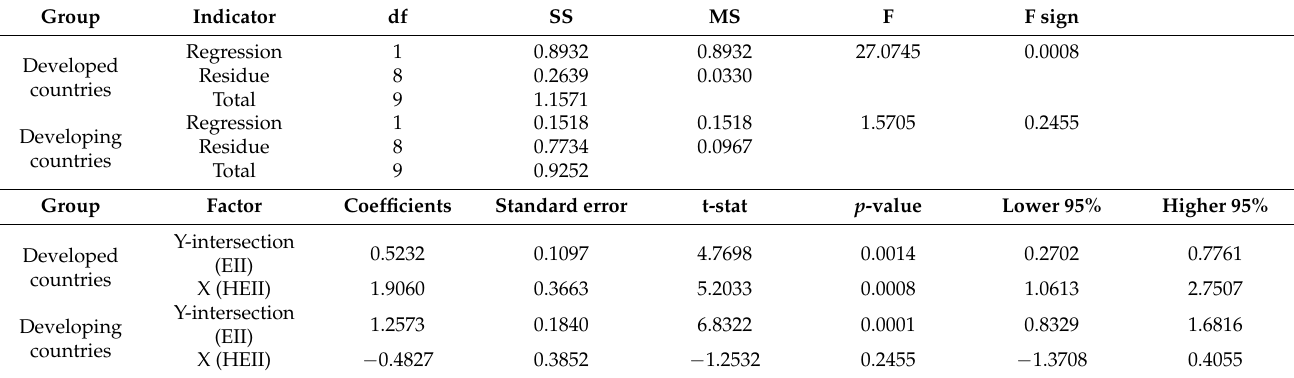
Table 6. Indicators of analysis of variance for the Energy Independence Index.